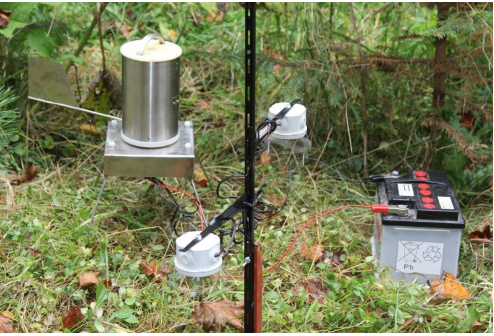
Figure 1. Installation of two rotating arm spore traps (RASTs) and one seven-day automatic volumetric spore trap (SAVST) in Hackerova skolka, SE Czech Republic.